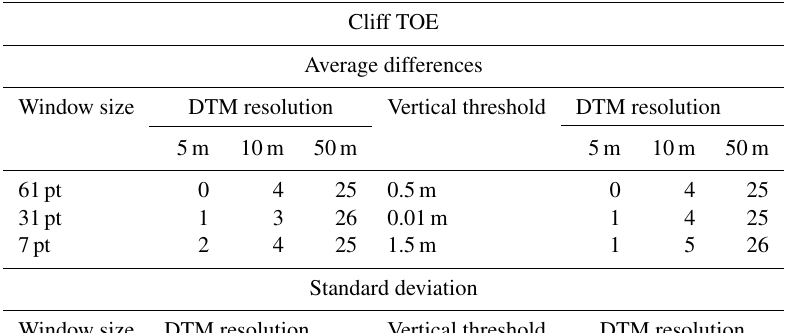
Table 4. Cliff toe average, standard deviation, maximum difference and number of samples for the sensitivity analysis to DEM resolution, window size for coastline smoothing and vertical